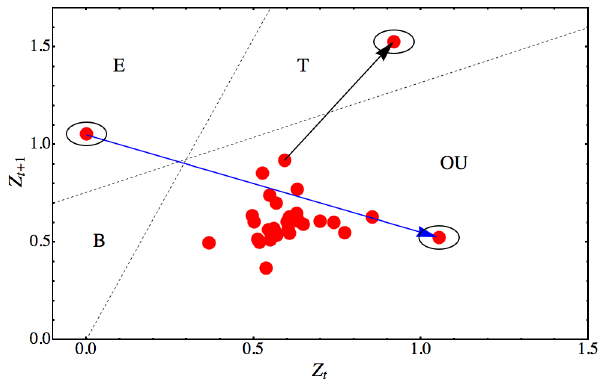
Figure 7. Failure Rate Phase Space Regimes of Long-term Repopulating HSCs. Phase space plot of the failure rate kinetic of a long-term repopulating HSC with long lifespan of T ~ 57 months. Points ( Z t , Z t z 1 ) in the plot (red) represent successive failure rates calculated every 2 months. To facilitate visualization, regions were separated by dotted lines. After initial expansion (region E, circled point), the kinetic transitions (blue arrow) into a regime (region OU), where it remains for most of clonal life. The behavior in region OU is governed by an Ornstein-Uhlenbeck iterative process (compare eq 4). The end of clonal life is indicated by the transition (black arrow) from region OU to the ‘‘terminal’’ absorbing point in region T (circled point). Region B is not visited by the dynamic trajectory and, therefore, empty.